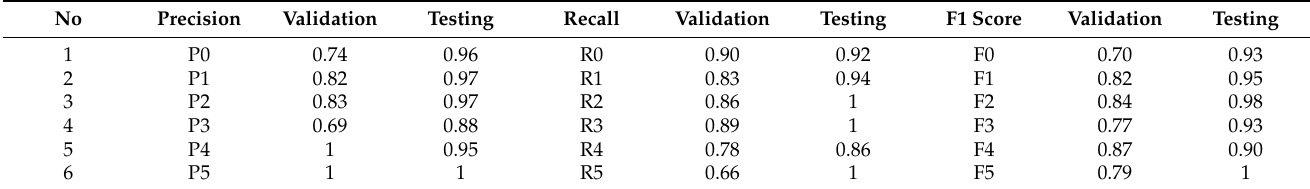
Table 7. LSTM precision, recall and F1 Score for validation and testing phase for six-class classification.